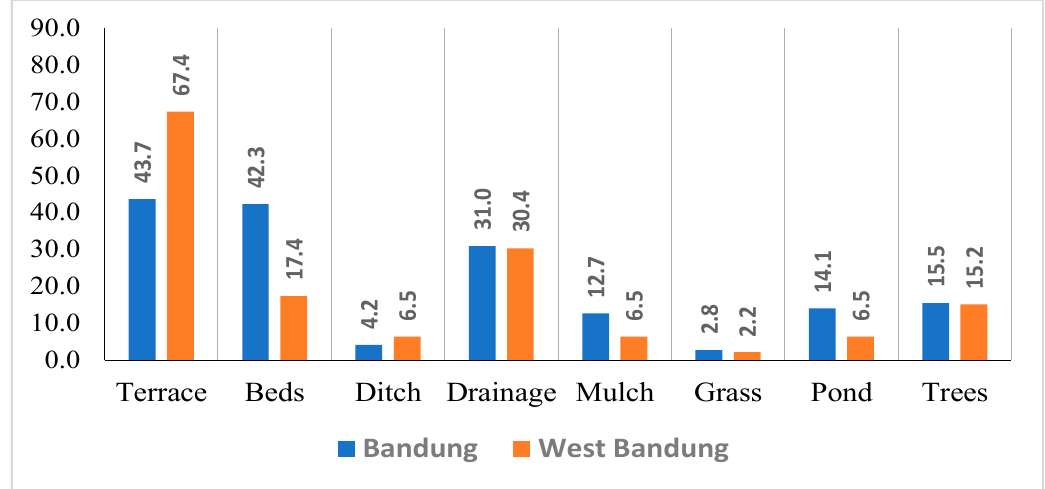
Figure 2. Distribution of farmers by type of conservation practices. Table 5. Double hurdle parameter estimates of factors affecting farmers on conservation practices. Participation Intensity Coef.